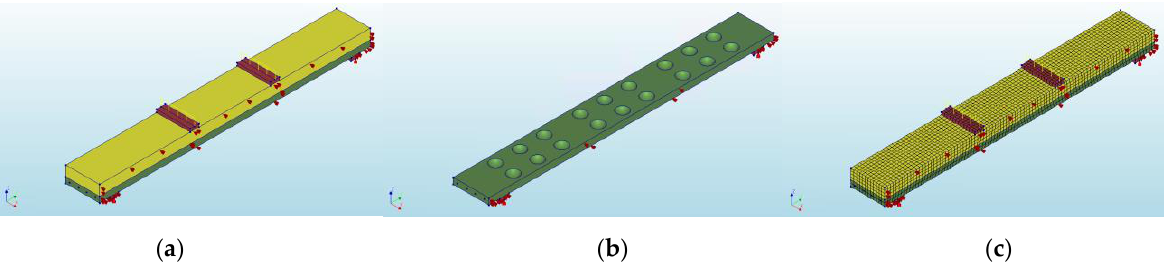
Figure 5. General view of the numerical model: ( a ) whole 3D slab model; ( b ) precast concrete layer; ( c ) meshed 3D model.